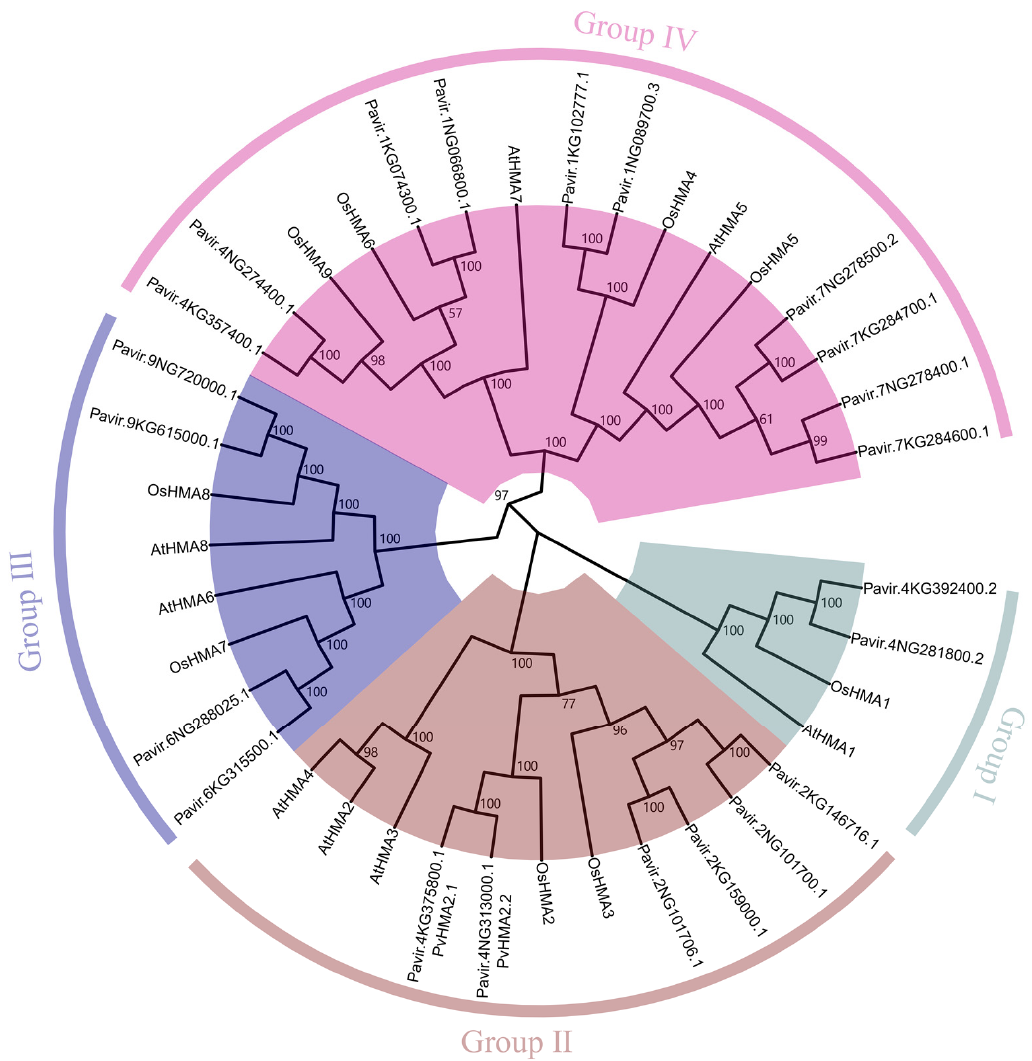
Figure 1. The unrooted phylogenetic tree for heavy-metal ATPase (HMA) proteins in Panicum virgatum , Arabidopsis thaliana , and Oryza sativa . Multiple HMA sequence alignment was first performed using MAFFT, and then a phylogenetic tree was constructed by MEGA 11, using the neighbor-joining method with 1000 bootstrap replicates. The numbers next to the branching point indicate the percentage of replicates supporting each branch. All HMAs are classified into four groups, which are marked by different colors. The sequence numbers of HMAs in P. virgatum , A. thaliana , and O. sativa are listed in Supplementary Table S1.